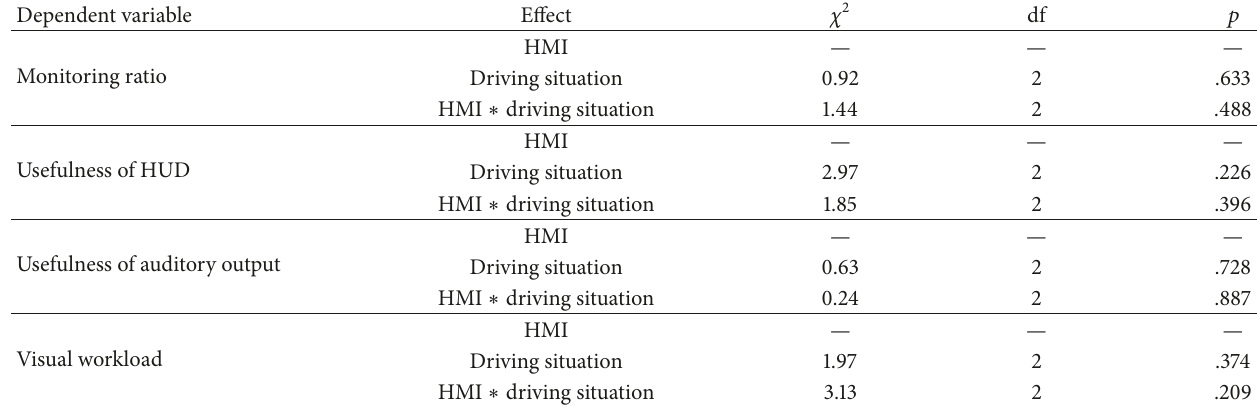
Table 3: Mauchly’s test against violations of the sphericity assumption.